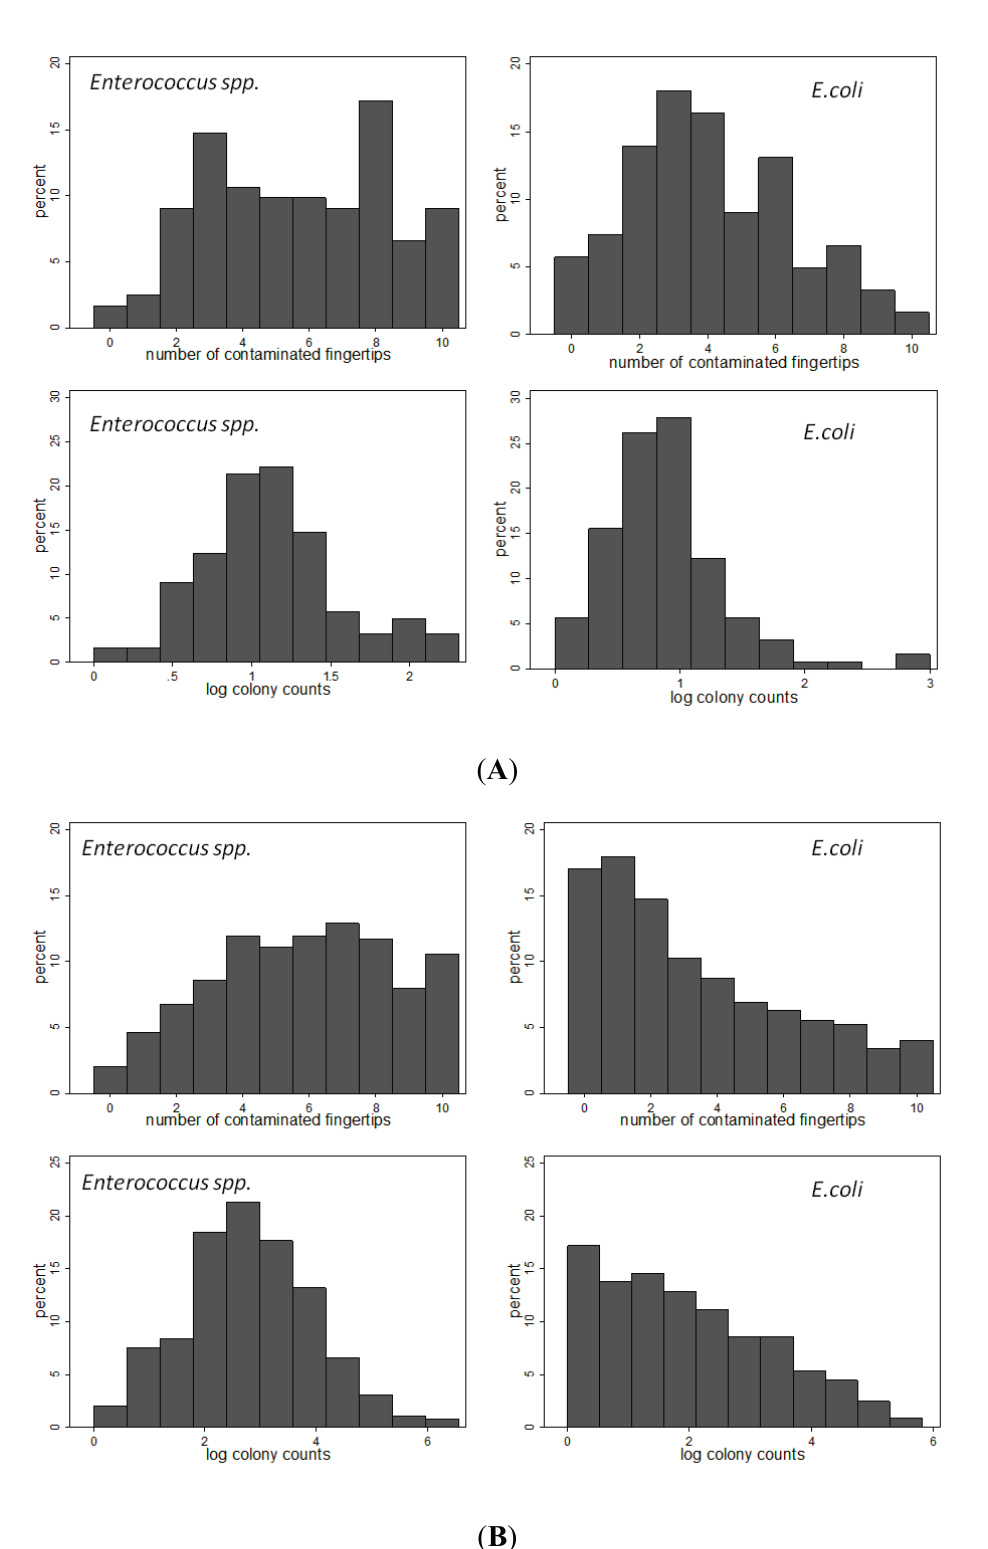
Figure 1. Distribution of number of contaminated fingers and log 10 colony